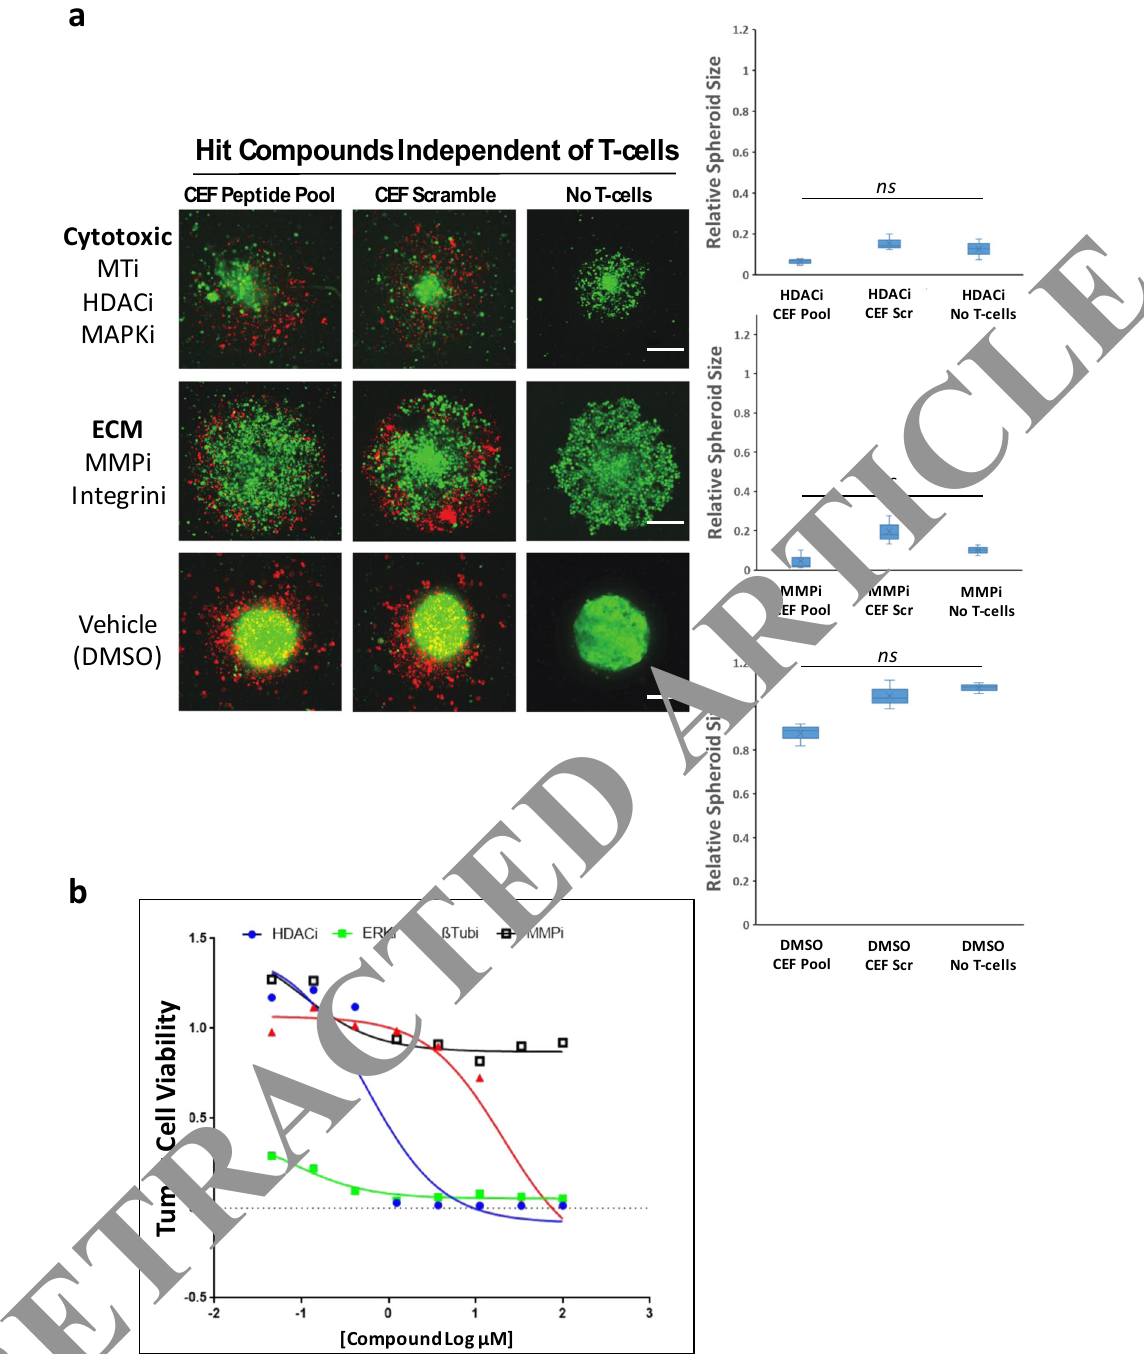
Fig. 4 Hit compounds that manifested anti-tumor phenotypes independent of T-cells. a Hit compounds from the primary screen were tested on T-cell/ spheroid co-cultures where both cell types were primed with the same antigen (CEF Peptide Pool), cell types were primed with different antigens (CEF Scramble) or spheroid monocultures with no T-cells (No T-cells). Cytotoxic compounds that targeted key cellular machinery exhibited anti-tumor properties independent of T-cell presence (MTi β -tubulin inhibitor, HDACi histone deacetylase inhibitor, MAPKi mitogen-activated protein kinase inhibitor). ECM-targeting compounds could be distinguished by their unique, though non-toxic, phenotypes (MMPi matrix metalloproteinase inhibitor). Spheroid size is quantitated in bar graphs on right, relative to DMSO controls (ns = not signi fi cant and error bars indicate standard deviation of three biologically independent samples). b Viability readout of spheroids from a using HCT116-Luc reporter spheroids in the presence of T-cells and hit compounds with matching viral antigens (CEF Peptide Pool). HDAC inhibitors and β -tubulin inhibitors demonstrated sigmoidal dose – response curves, ERK inhibitors demonstrated high potencies and MMP inhibitors did not signi fi cantly affect tumor spheroid cell viability.